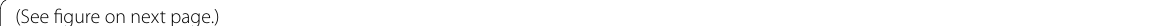
figure on next Fig. 3 Tetrandrine affects osteoclastogenesis by promoting the ubiquitination of TRAIL. A The mRNA expression level of TRAIL in BMMs with 0, 0.25, 0.5, 1 μM of Tetrandrine was carried out with RT-qPCR. B The expression of level of TRAIL in BMMs treated with specified concentrations of Tetrandrine for 5 days was detected using western blot. C Immunofluorescence image for showing TRAIL expression in cytoplasm; scale bar 200 μm. D The co-IP assay was used to detect the effect of Tetrandrine on TRAIL ubiquitination with or without RANKL. E–G The transfection = efficiency of TRAIL silencing (si #1, si #2, si #3) and TRAIL overexpression (TRAIL vector) detected via RT-qPCR and western blotting. H–K BMMs were transfected with siTRAIL and TRAIL vector, the expression of the related genes and proteins that were revealed by RT-qPCR and western blotting. All experiments were carried out in triplicate. The results were presented as mean SEM. * P < 0.05, ** P < 0.01, *** P < 0.005 and **** P < 0.001 as ± compared with the control